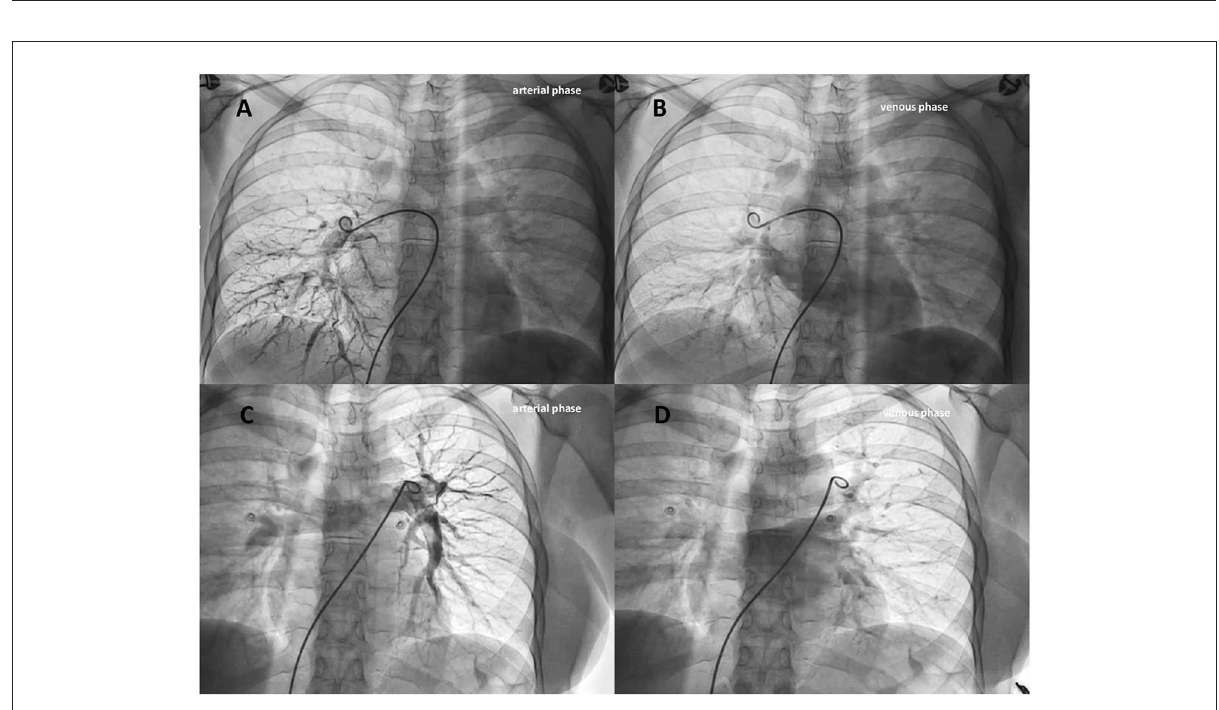
FIGURE4 Selective right (A,B) and left (C,D) pulmonary angiograms (arterial and venous phases) didn’t show abnormalities of the pulmonary vasculature or arteriovenous